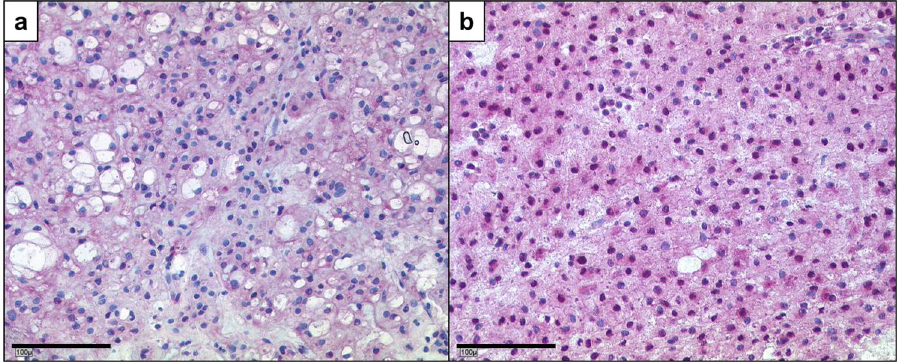
Figure 5. Differences of HOXA10 protein levels in clival and sacral chordomas. Immunohistochemistry of HOXA10 shows a very weak cytoplasmic staining of HOXA10 protein in clivus ( a ) and a nuclear positivity in the sacrum chordomas ( b ).